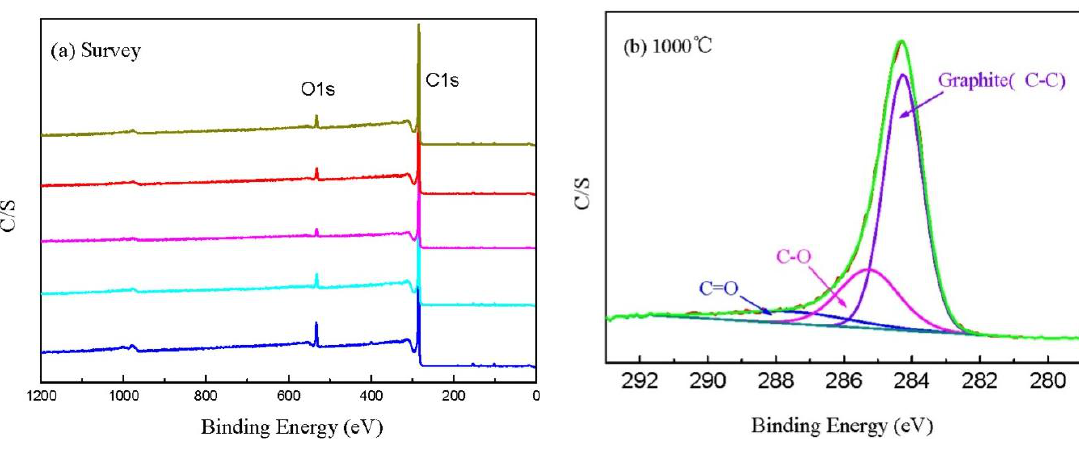
Figure 6. X-ray photoelectron spectroscopy (XPS) curve of CBCFs at various temperatures: ( a ) XPS survey spectra; ( b ) XPS spectra of the C1s